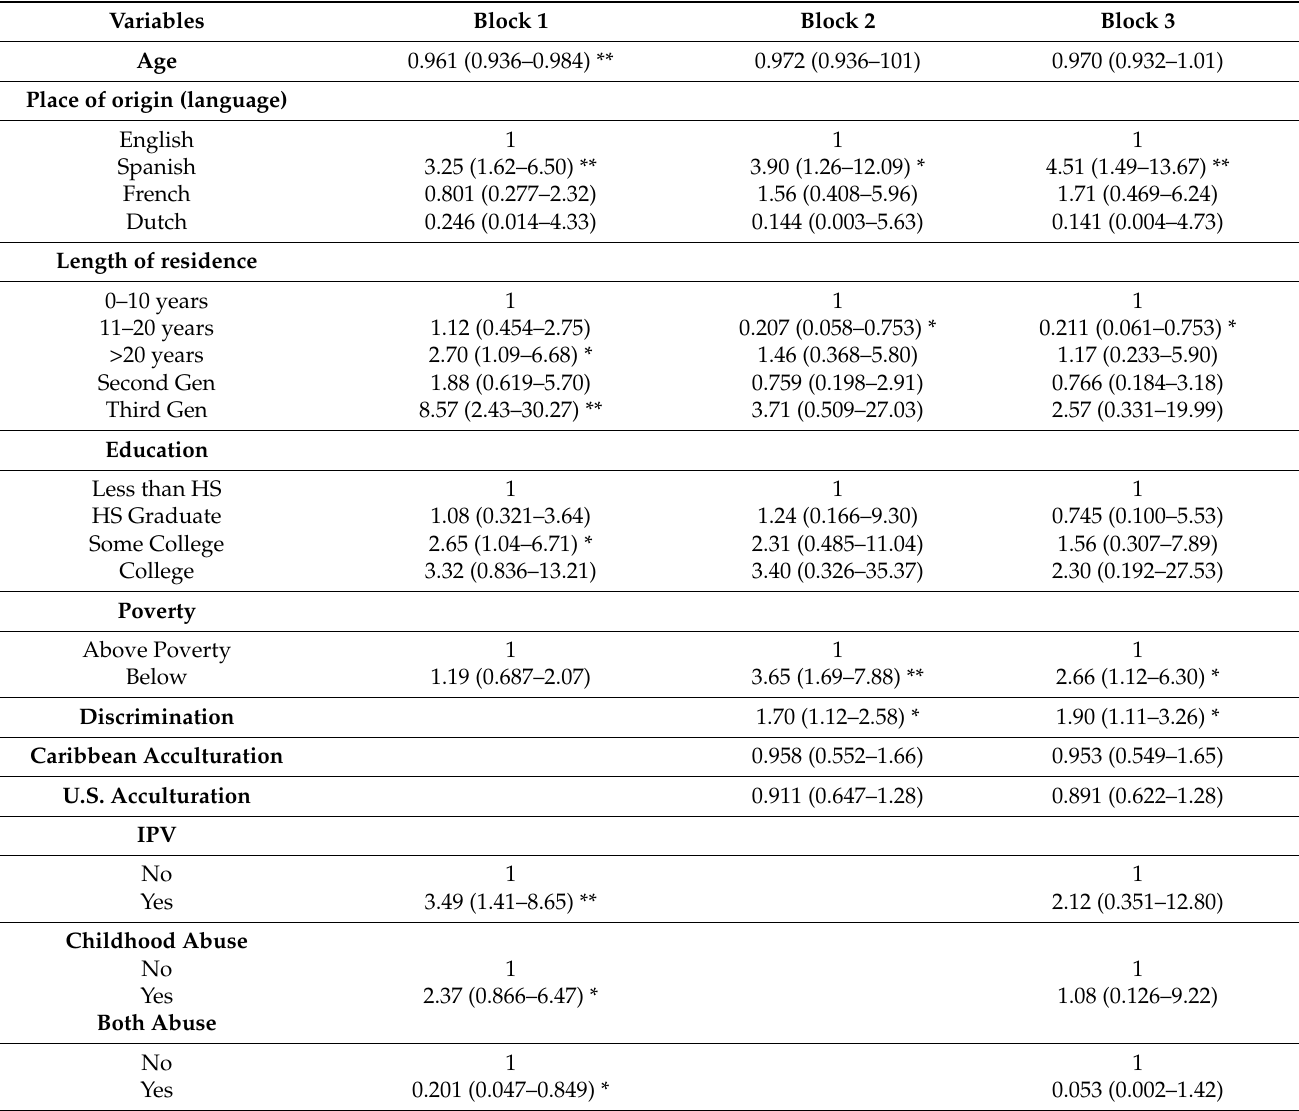
Table 3. Multivariate Analysis Examining Domestic Violence, Acculturation, Discrimination and Demographic Factors on Lifetime Mood